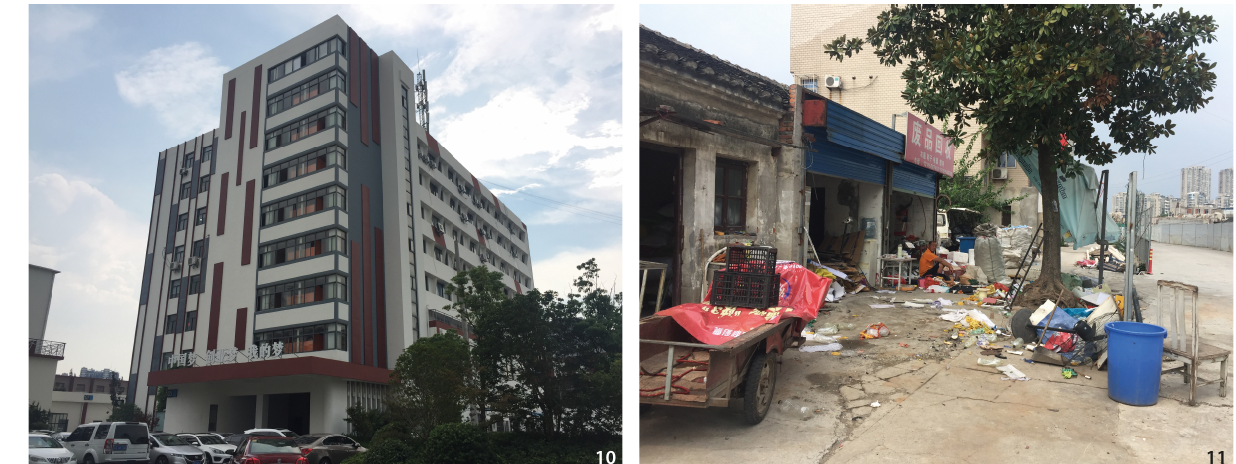
Figure 10 Synthetic Fiber Factory after renovation (now Five Star Wisdom Park) (Source: the author). Figure 11 Shantytowns directly opposite Five Star Wisdom Park (Source: the